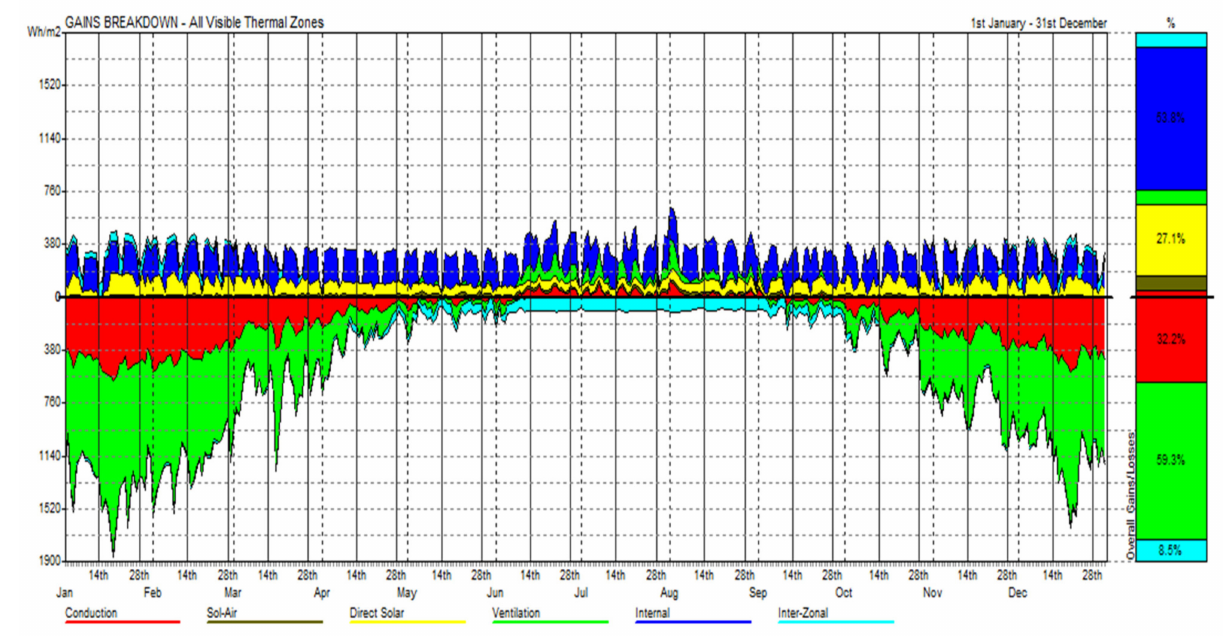
Figure 25. Energy gains breakdown.